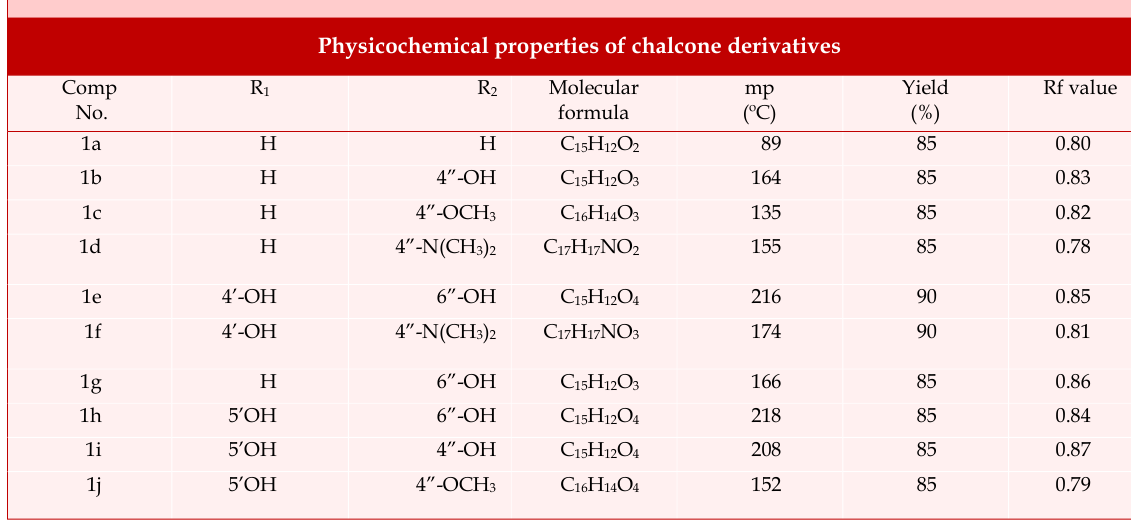
Physicochemical properties of chalcone